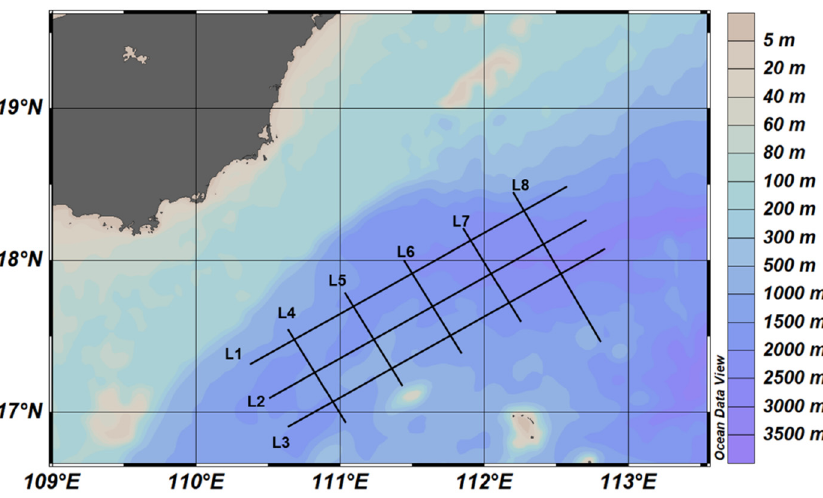
Figure 7. Water depth and line distribution map of the survey area.